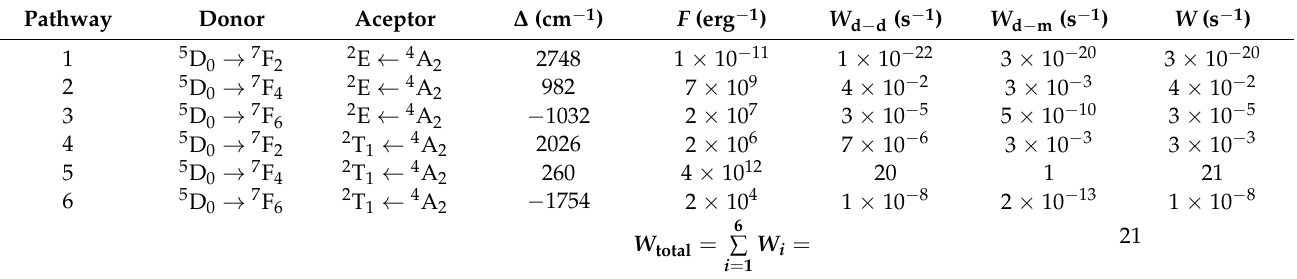
Table 1. Theoretical ET rates at room temperature for the [CrEuL 3 ] 6+ complex. The donor–acceptor = 9.3 . The values were calculated using S M distance is R d − f energy difference between the donor and acceptor transitions. W is the sum of W d − d and W d − m in the same pathway, and the total rate W total is the rate obtained by summing all